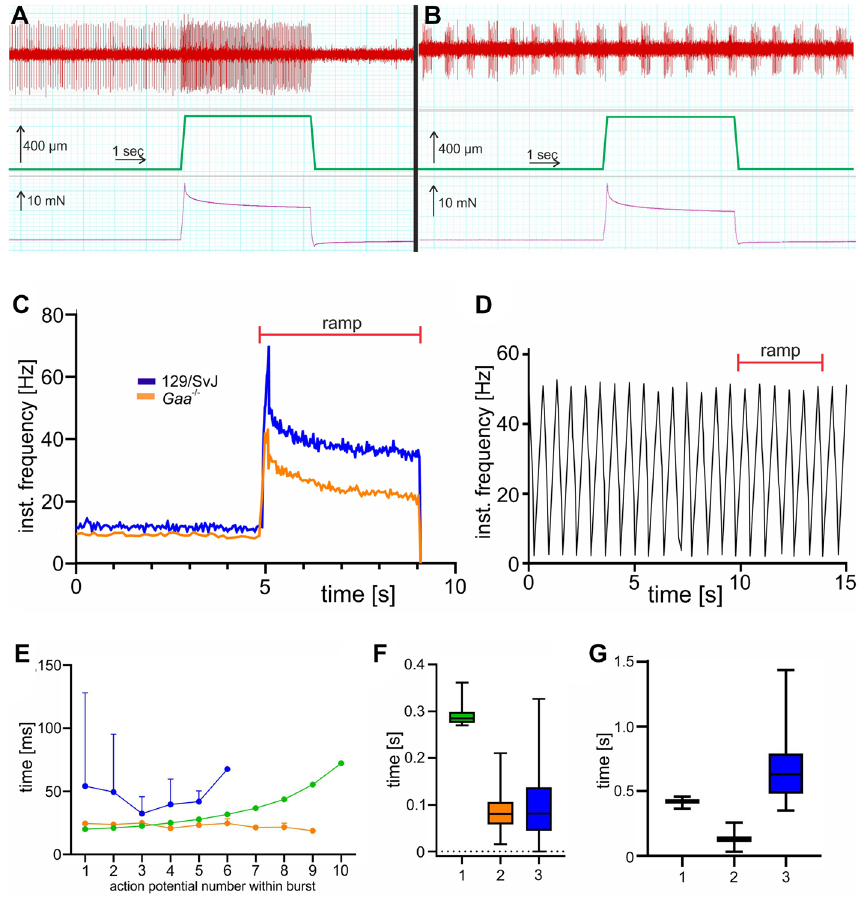
Figure 2. The response to stretch in muscle spindles from Gaa −/− mice is impaired. A representative example for the response of muscle spindle afferents to a ramp-and-hold stretch from 129/SvJ wildtype mice is shown in panel ( A ). Muscle spindles from wildtype mice had a constant resting discharge of approximately 10 Hz and responded to stretch with an increase in their instantaneous frequency ( A ). In contrast, 70% of the muscle spindles from 8-month-old Gaa −/− mice (orange line in panel ( C )) responded to stretch, but had a lower frequency at all time points during a stretch compared to age-matched 129/SvJ wildtype mice. Approximately 30% of the 8-month-old Gaa −/− mice fired bursts at rest and did not respond to stretch ( B ). In some spindles, the bursts were rather regular even during a ramp-and-hold stretch ( D ). In other muscle spindles from 8-month-old Gaa −/− mice, which showed the bursting behavior at rest, the bursts varied with respect to the action potential frequency during the bursts ( E ), the duration of the bursts ( F ) and the interburst interval (duration of the silent period; ( G )). Three representative spindles from three different 8-month-old Gaa −/− mice are shown to illustrate the spectrum of the busts. The red bars in panels ( C,D ) indicate the duration of the ramp-and-hold stretch. The middle parts of panels ( A,B ) show the length change (5% of L 0 ) and the lower parts show the passive tension generated by the muscle in response to the stretch. No difference between wildtype and Gaa −/− mice was observed with respect to the passive tension generated in response to the length